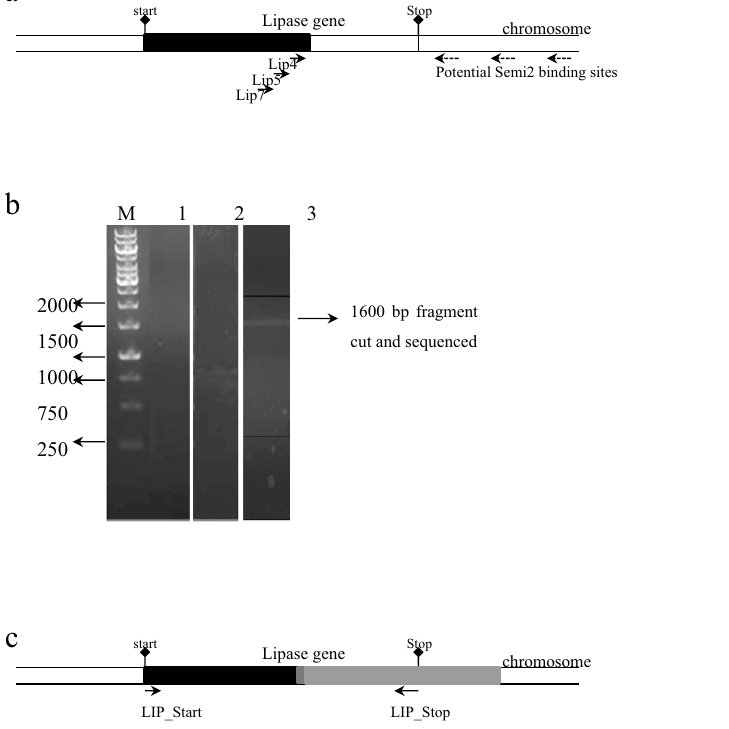
Figure 2. Cloning strategy for the KE38 cold-adapted lipase gene. ( a ) Schematic illustration of the lipase gene on the bacterial chromosome. The black box represents the initially sequenced 1100 bp region of the lipase gene. Arrows indicate primer binding sites. Start and stops codons of the lipase gene are also shown. ( b ) Products of the three rounds of nested-PCR reactions are shown. M molecular weight markers, 1: first round of PCR with primers Lip7 and Semi2, 2: the second round of PCR with primers Lip5 and Semi2, 3: third round of PCR with primers Lip4 and Semi2. Numbers on the left indicate the sizes of the relevant bands in base pairs. Genomic DNA was used as a template for the first round of PCR, while products of the previous round of PCR were used as a template for the second and third round of PCRs. A band of 1600 bp in length observed after the third round of PCR was cut from the gel and used for direct sequencing. ( c ) Schematic illustration of the lipase gene on the bacterial chromosome. The black box represents the initially sequenced 1100 bp region of the lipase gene, dark and light grey boxes represent the 1600 bp cloned region by chromosome walking, and the dark gray box alone represents the overlap sequence between the 3 ′ end of the initially sequenced and the 5 ′ end of the cloned fragment. LIP_Start and LIP_Stop are the primer binding sites used for the amplification of the complete lipase gene